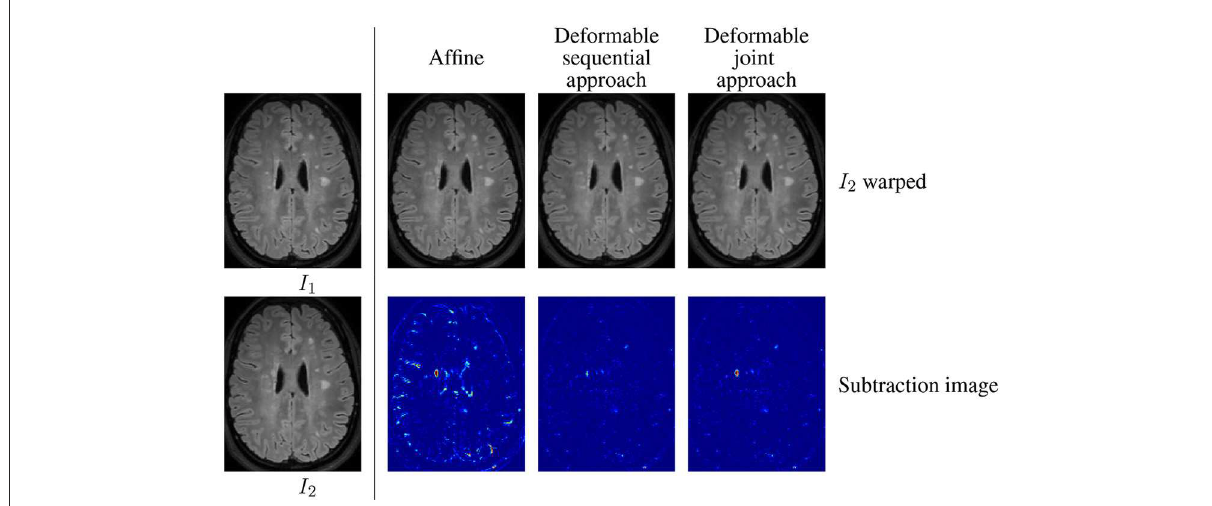
FIGURE1 Warped follow-up images and subtraction images obtained with the sequential affine and deformable registration pipelines and the proposed joint deformable approach, on an example of the dataset described in COM